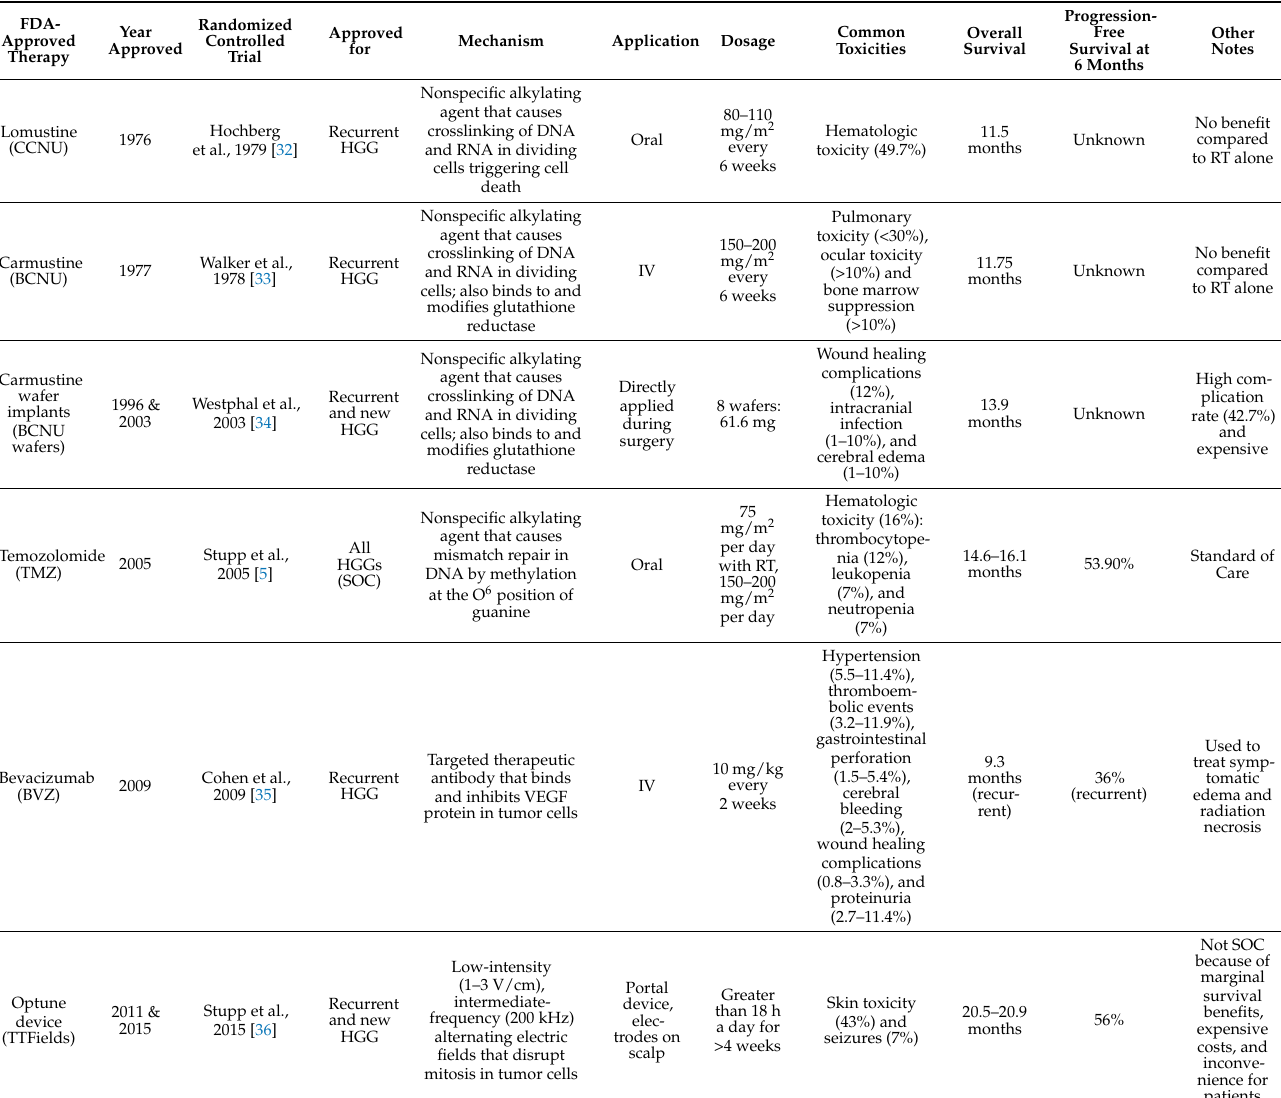
Table 4. List and information on FDA-approved therapies for high-grade